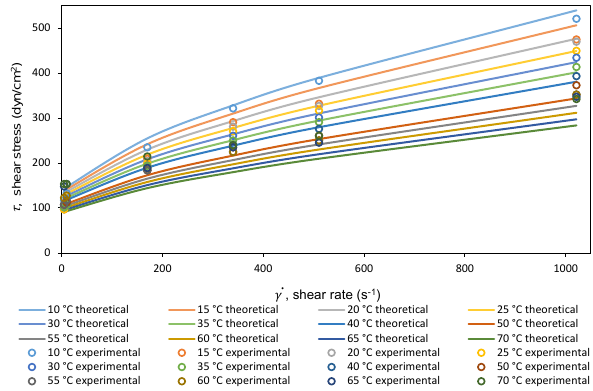
Figure 9: Experimental shear stress and data predicted by the mod- ified Herschel-Bulkley model vs. the shear rate in the temperature range of 10-70 ∘ C.